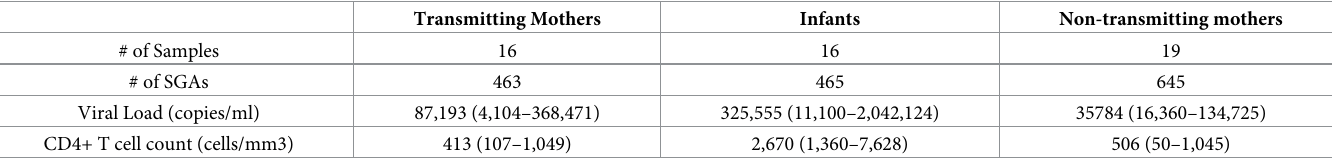
Table 1. Comparison of samples from Non-transmitting and transmitting mother-infant pairs. Transmitting Mothers Infants Non-transmitting